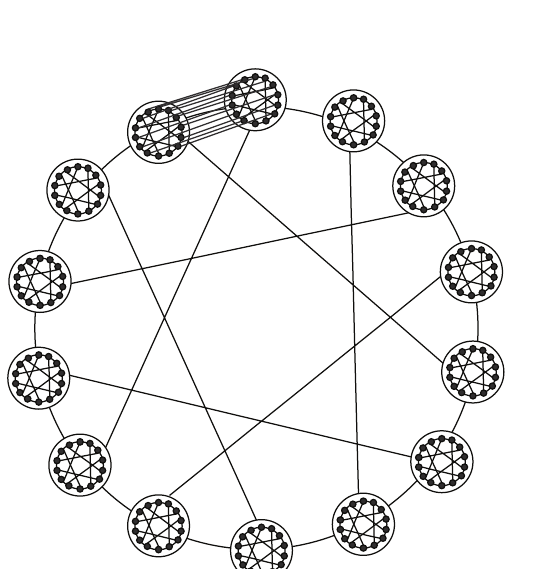
Figure 11: A Heawood graph [12].